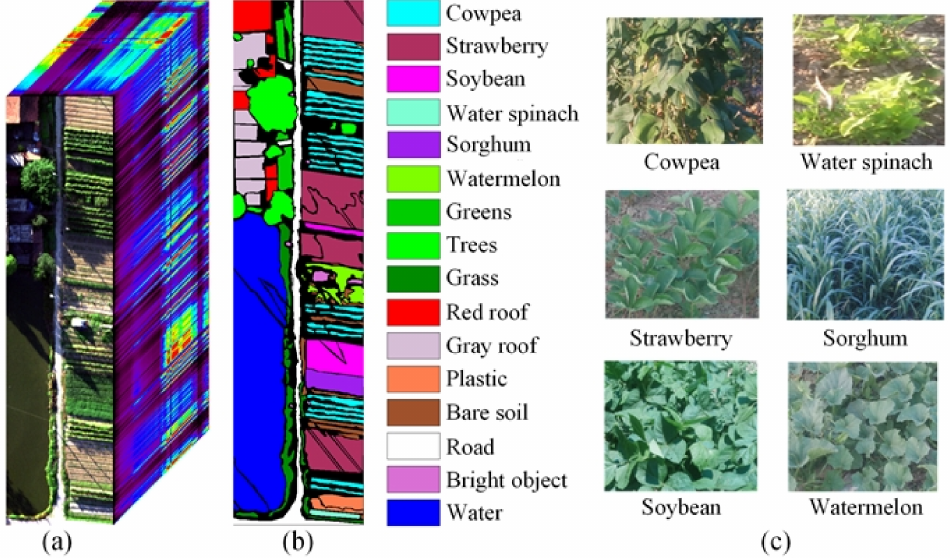
Figure 3. The HanChuan dataset: ( a ) Hyperspectral image; ( b ) Ground truth; ( c ) Typical crop photos in the study area.